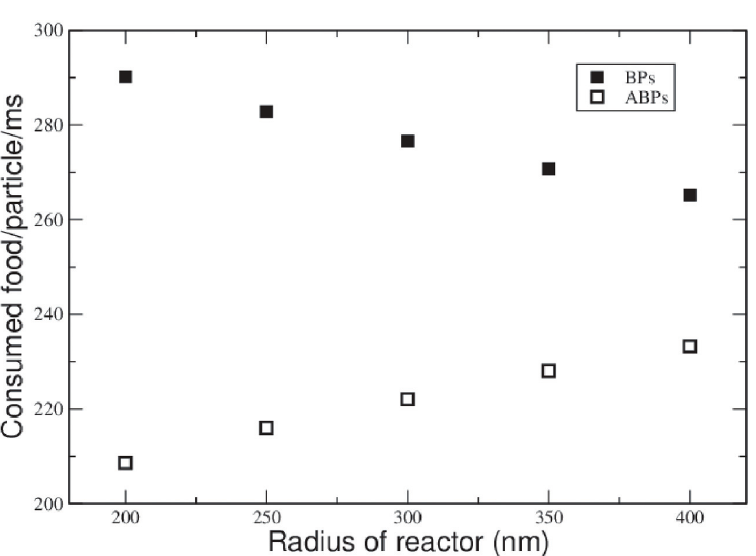
Fig 3. Stationary food consumption. Food consumption rates of particles for different sizes of the reactor. As a result of the bias of their density distributions, ABPs consume less food that BPs, exhibiting anti-chemotaxis. With increasing size of the reactor, the ratio of activated to inactive APBs is diminishing and their food consumption rates are approaching those of the BPs.